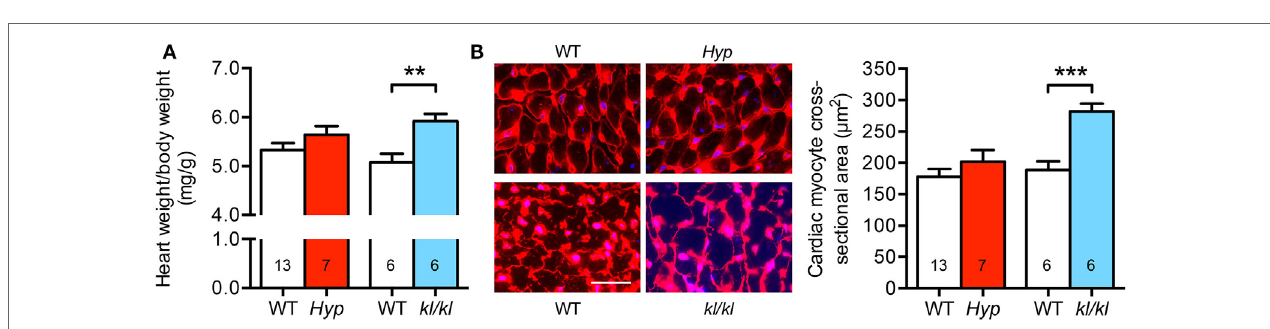
FigUre 2 | Development of cardiac hypertrophy in kl/kl mice. (a) The relative heart weight to body weight ratio is increased only in kl/kl mice. (b) Immunofluorescence co-staining for wheat germ agglutinin (WGA) Alexa Fluor555 (red) and cell nuclei (blue) demonstrates enlarged size of cardiac myocytes in kl/kl mice but not in Hyp mice (magnification, 63 × ; scale bar, 25 µm). Values are presented as mean ± SEM; numbers in each bar graph represent the n- values used for the respective measurement; ** P < 0.01, *** P < 0.001.